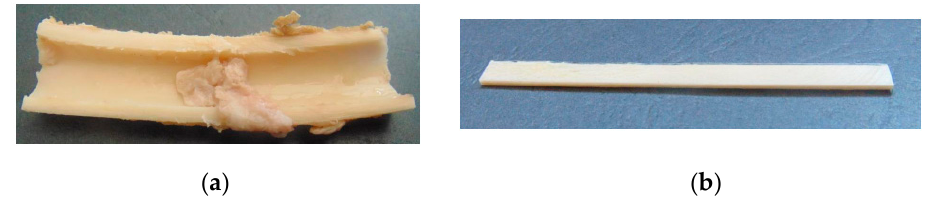
Figure 1. ( a ) Cortical bone after the execution of the longitudinal cut; ( b ) TPB specimen.